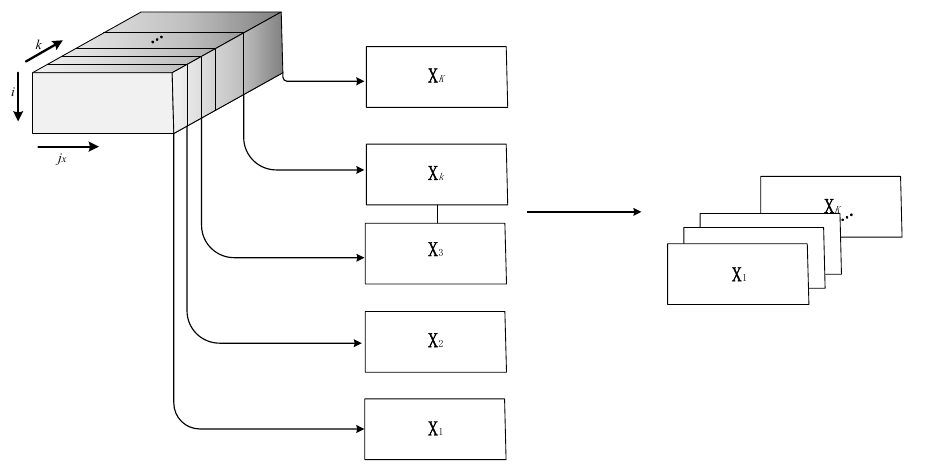
Figure 5. The extraction process of the time slices.